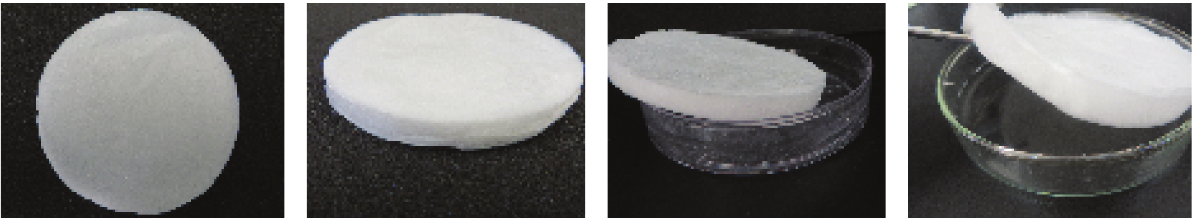
Figure 2: Photograph of capsaicin-collagen sponge.